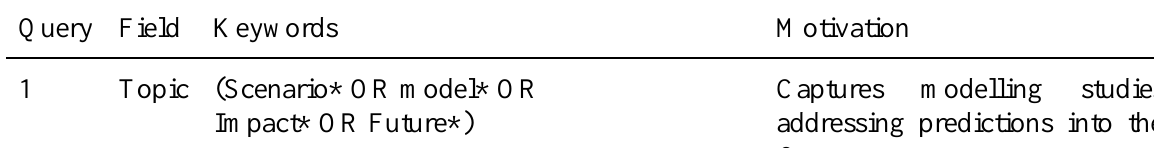
Table A3.1: Search terms used for the literature review. Query